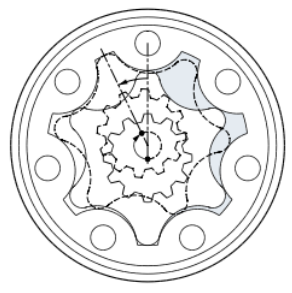
Figure 11. Inside the SAUER DANFOSS hydraulic